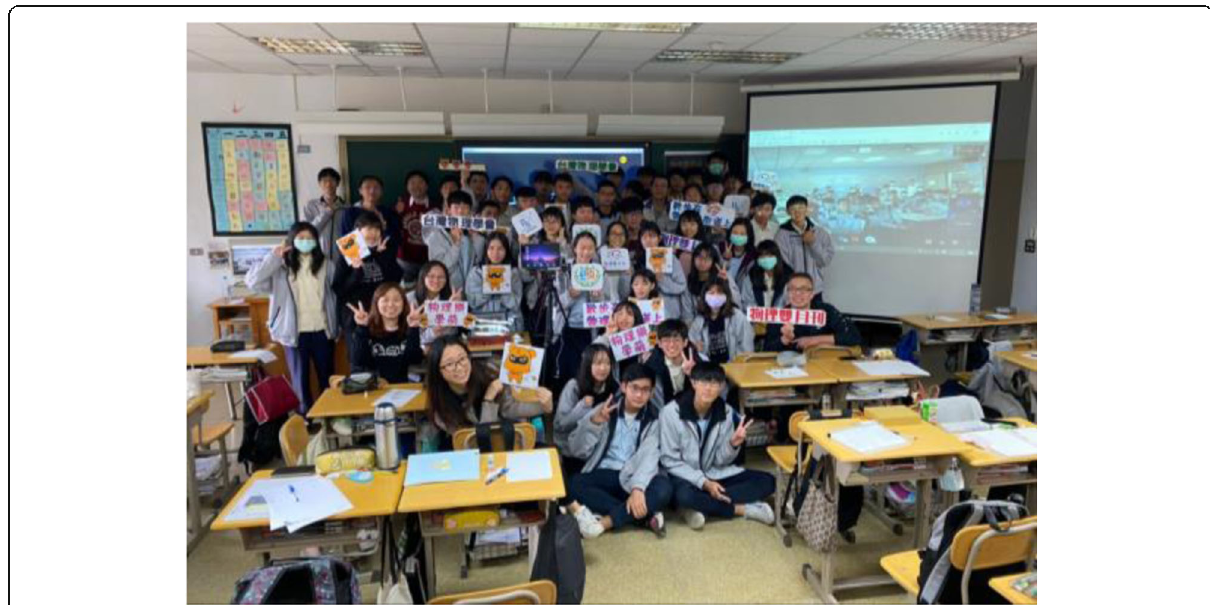
Fig. 8 The popular science talk, one of the events of Taiwan Physics Hub, to introduce senior high school students in Taoyuan how to perform VPython simulation for physics studies. Students in Hsinchu participated the talk